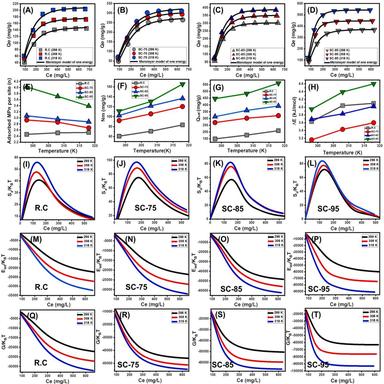
Shows fitting of the MPn adsorption results with Monolayer model of one energy site (A, B, C, and D), the change in the number of adsorbed molecules per site with temperature (E), the change in the active sites density with temperature (F), the change in the saturation adsorption capacities with temperature (G), the change in adsorption energy with temperature (H), the change in the entropy properties with temperature and the tested concentrations (I, J, K, and L), the change in the internal energy properti